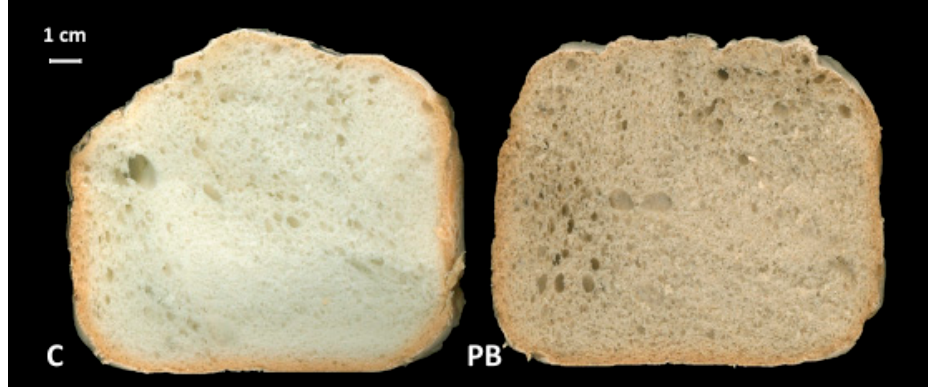
Figure 3. Appearance of control and parchment enriched